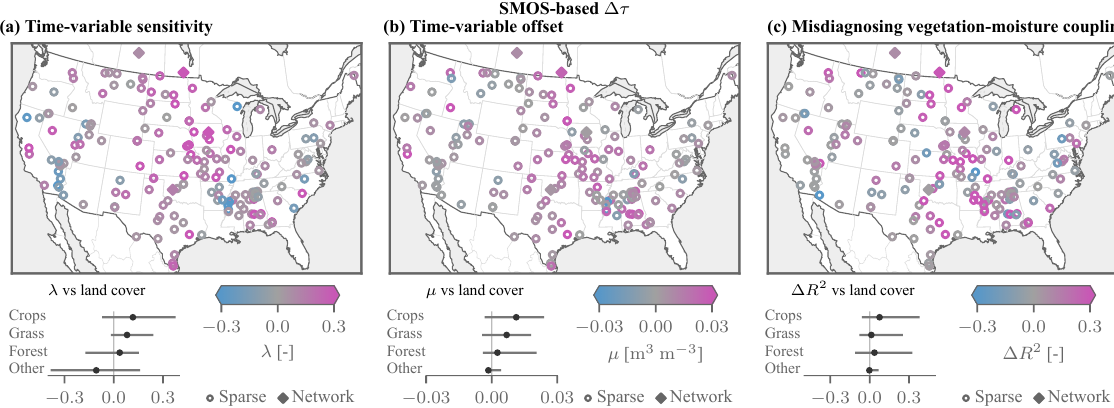
Figure 7. Time-variable biases and (cid:49)R 2 coupling metric across the contiguous US obtained using the SMOS τ product, shown for the network sites and the sparse sites (only those with > 250 valid SMAP observations). (a) The time-dependent sensitivity parameters λ are predominantly positive, and the largest magnitudes are found over croplands and grasslands. (b) The additive biases exhibit a similar spatial pattern. (c) The degree of association R 2 between anomalies of vegetation τ and soil moisture is commonly higher for SMAP than for in situ soil moisture ( (cid:49)R 2 >